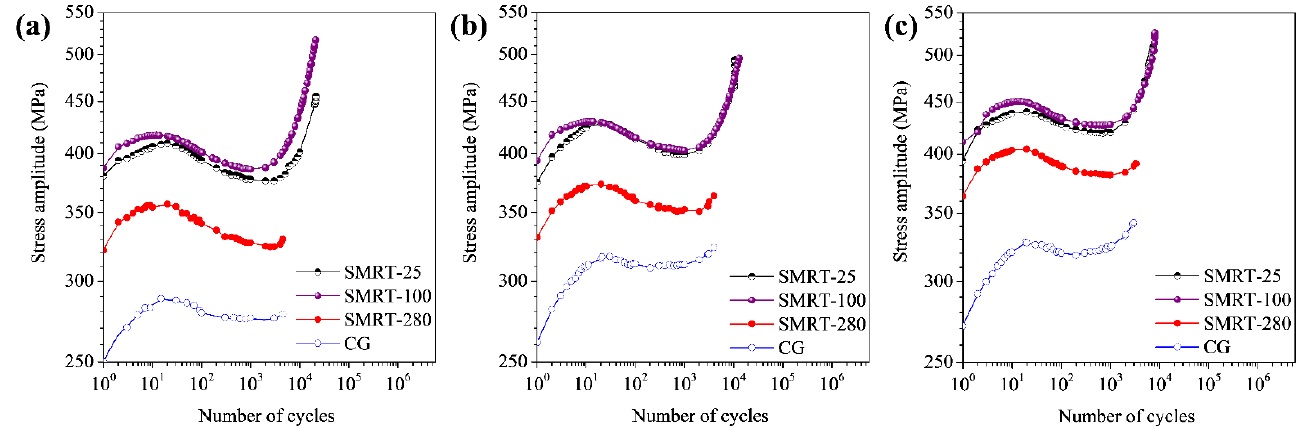
Figure 5. Cyclic stress amplitude curves of SMRT samples prepared at different temperatures and the CG sample during fatigue at a total strain amplitude of ( a ) 0.50%, ( b ) 0.55% and ( c ) 0.60%.